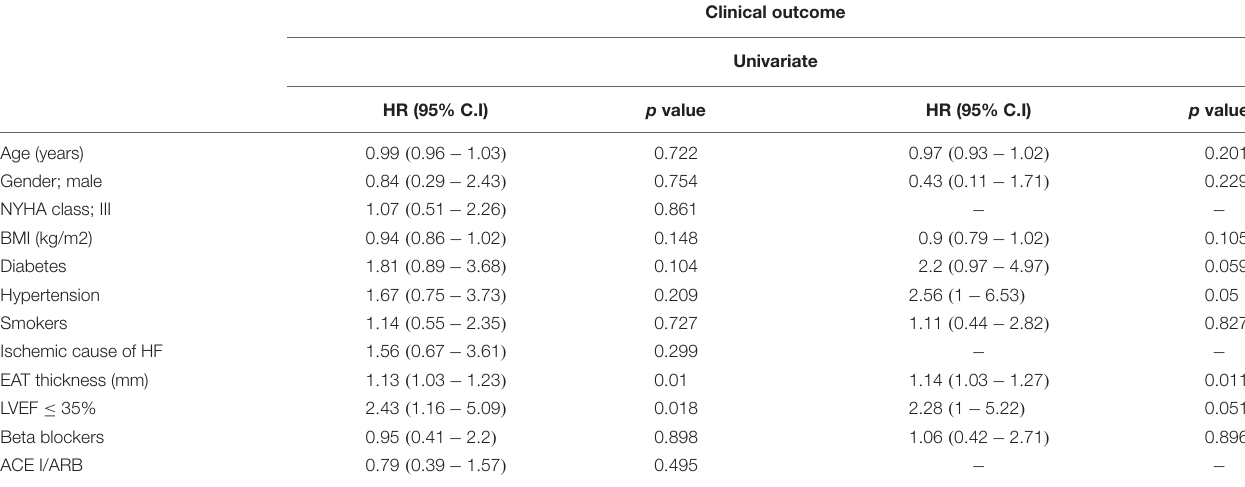
Clinical outcome